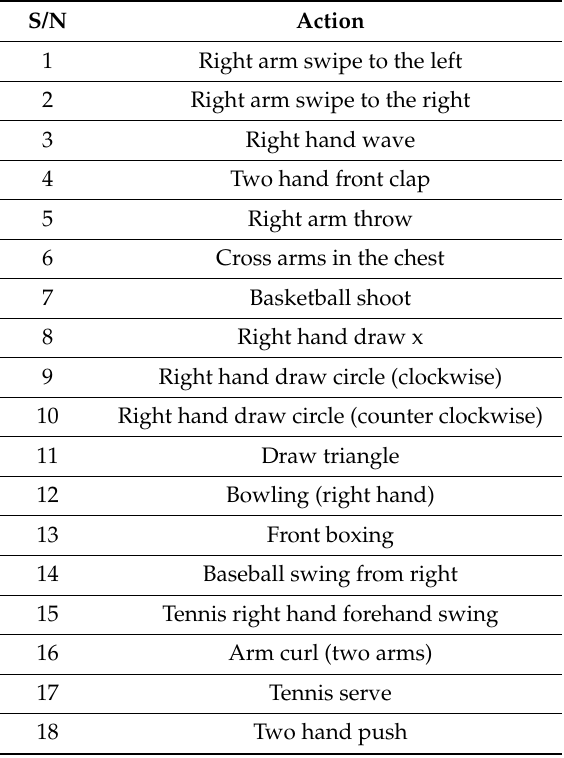
Table 1. 27 actions of University of Texas at Dallas Multimodal Human Action Datasets (UTD-MHAD).